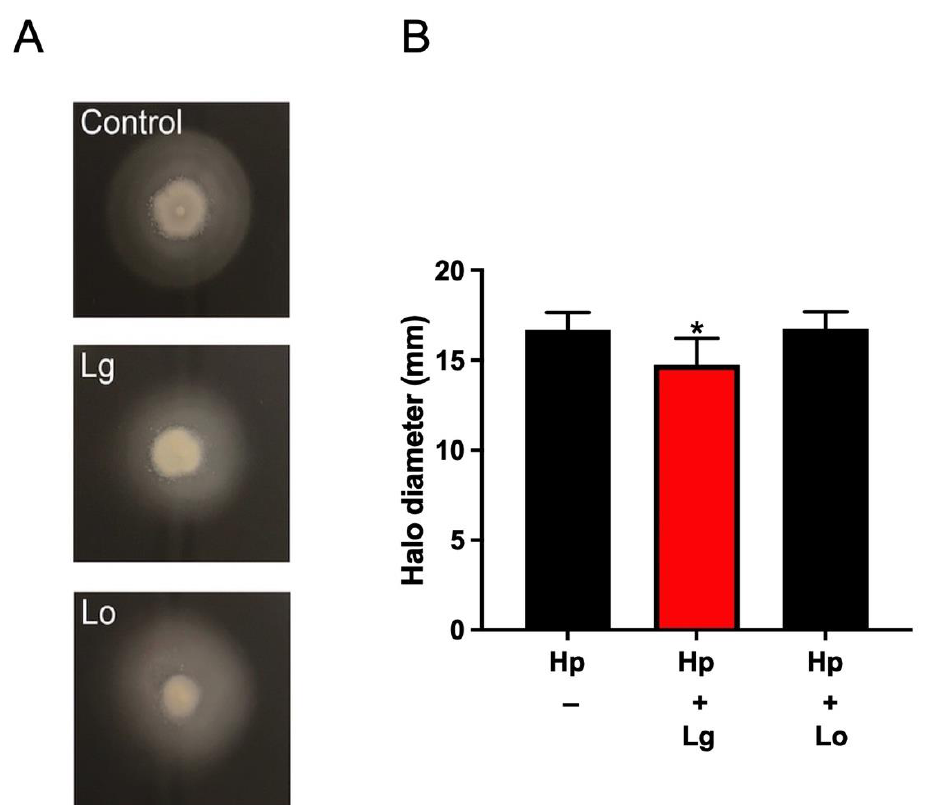
Figure 2. L. gasseri CM reduces H. pylori motility. The effect of lactobacilli CM on the motility of H. pylori . ( A ) Bacteria were stab inoculated with a pipette tip in Brucella motility agar and incubated at 37 °C under microaerobic conditions for 5 days. A representative agar plate is shown. ( B ) The halo diameter was measured in three independent experiments. Data are presented the means and standard deviation of duplicate samples and are average of three independent experiments. * p < 0.05.